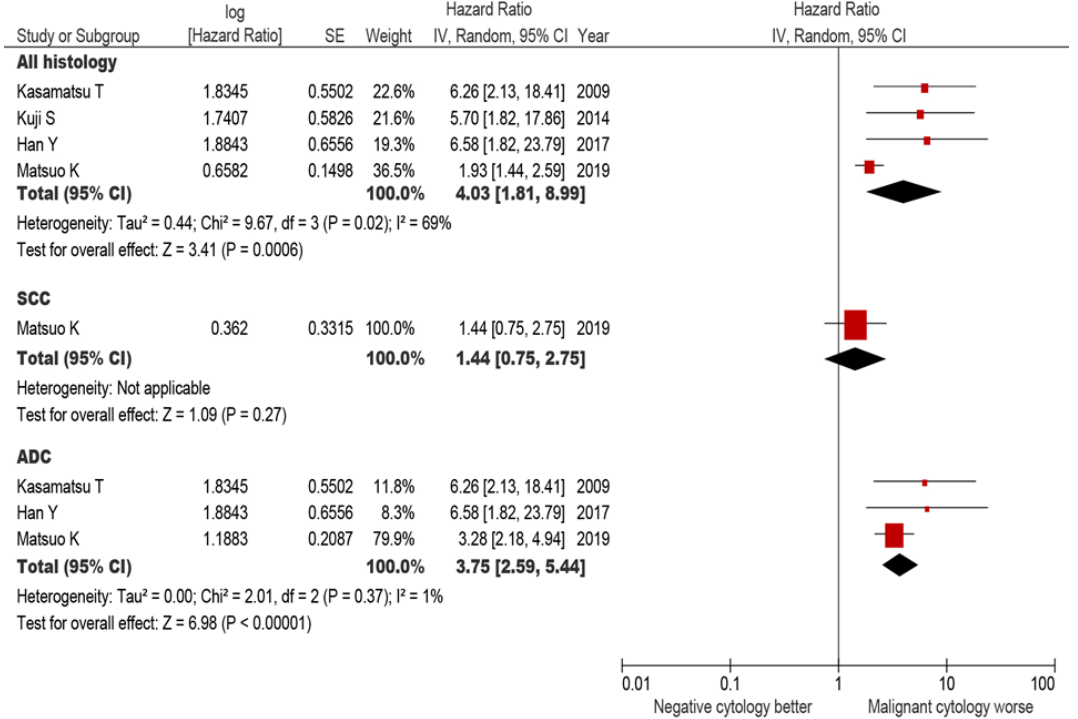
Figure 7. All-cause mortality for malignant peritoneal cytology (systematic review and meta-analysis). A forest plot from a random effects meta-analysis of six studies including our study stratified by inclusion criteria and ordered within stratum by year of publication and relative weight